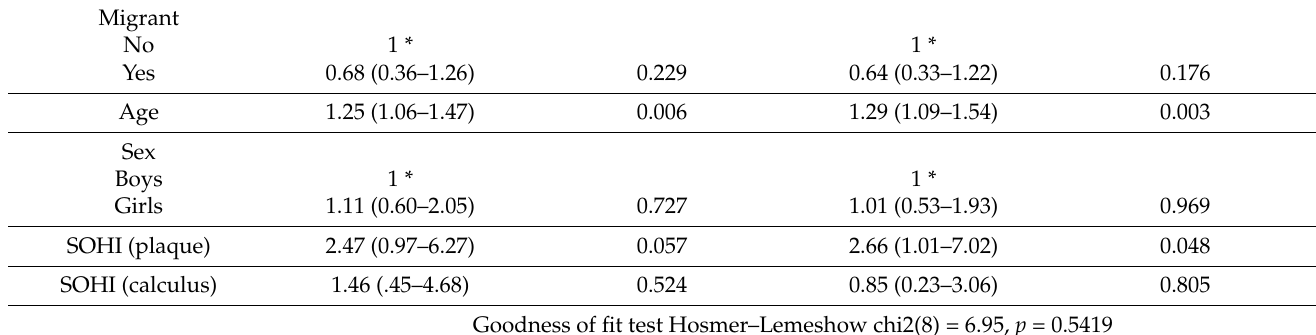
Model 2: Caries Prevalence in Permanent